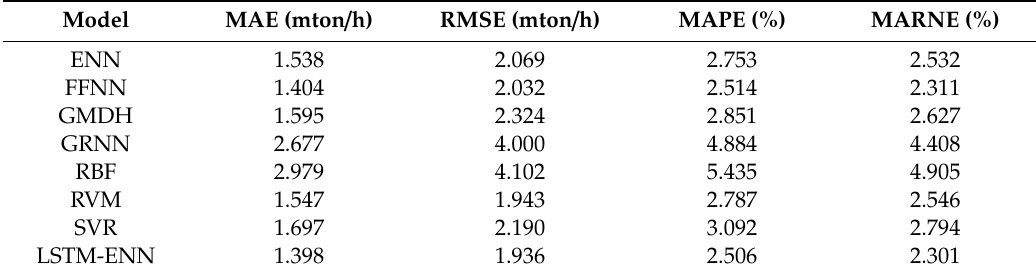
Table 8. Models comparison for Case Study #1.